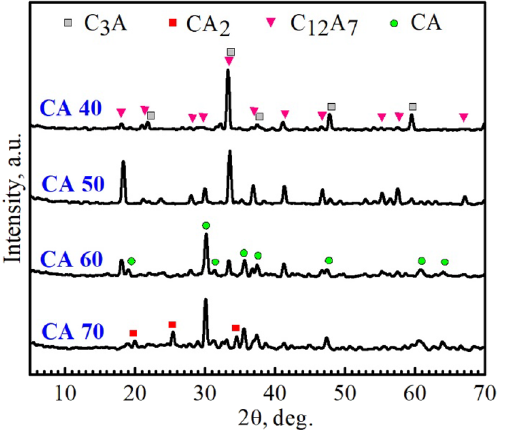
Figure 1. Powder XRD patterns of the compacted specimens sintered at 1250 °C.